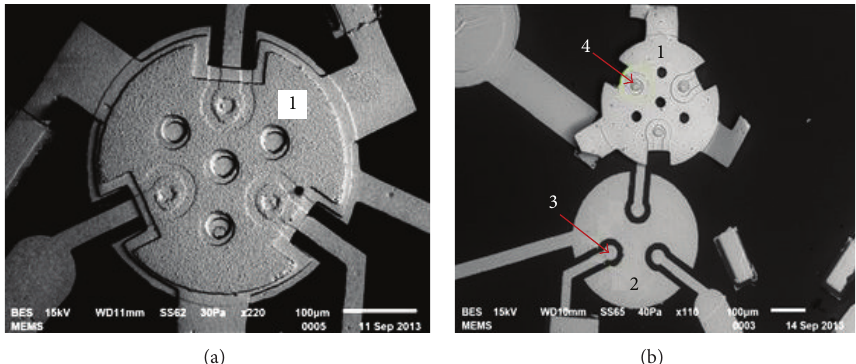
Figure 1: SEM images of an electrostatic MEMS switch: (a) an assembled device without hermetic housing, (b) movable cover (1) and fixed base (2). In the panel (b) the movable part was bent back prior to analysis; numbers (3) and (4) are marked contacts on the fixed and movable parts, respectively.